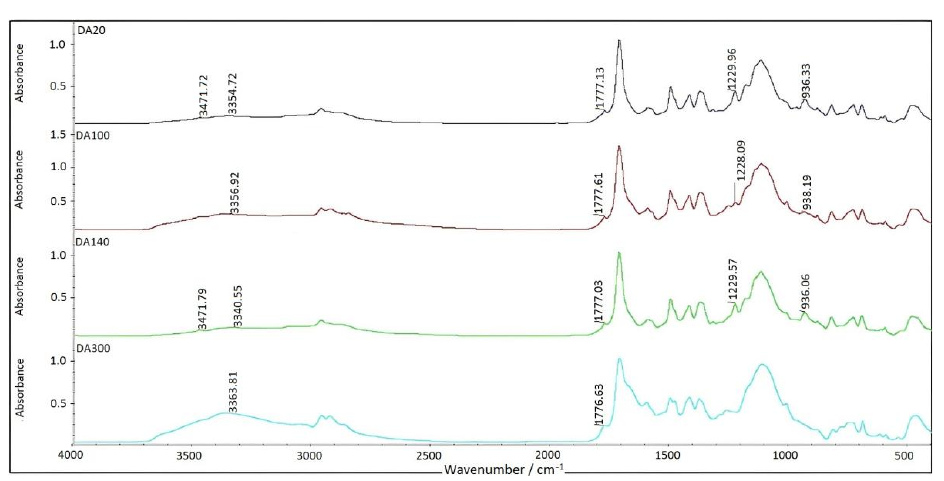
Figure 17. FTIR spectrum of OMPS/bisphenol A ‐ furfuryl amine oxazine (1:1).